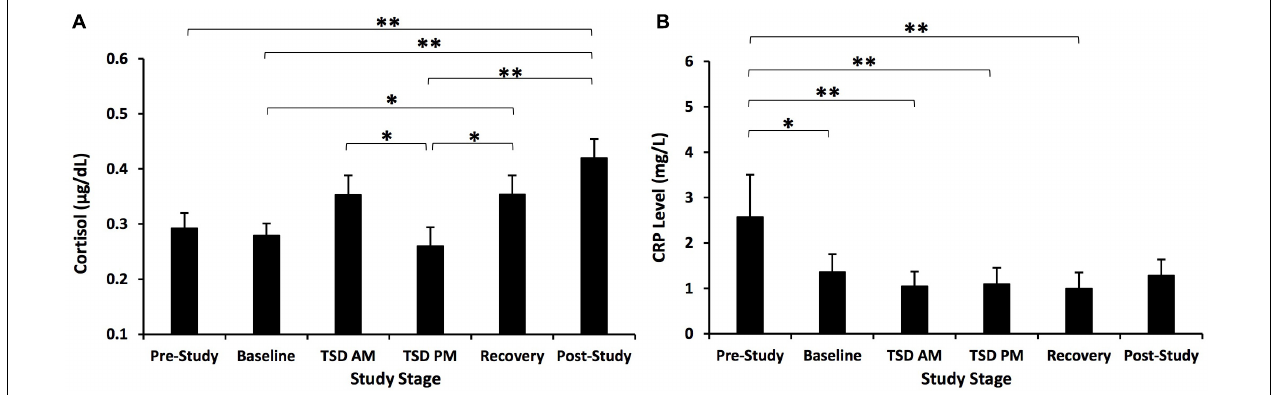
FIGURE 3 | Cortisol and C-reactive protein (CRP) changes across the study. (A) Cortisol showed a significant change across the study. Post hoc analyses showed that post-study cortisol was significantly higher than pre-study, baseline, and TSD PM cortisol. Cortisol at TSD AM was significantly higher than at TSD PM. Recovery cortisol was also significantly higher than at baseline and TSD PM. (B) CRP showed a significant time effect across the study. Post hoc analyses showed that pre-study CRP was significantly higher than CRP at all other time points except for post-study. N = 31 for the recovery point in (A) due to one participant withdrawn from the study during recovery night 1 and for the post-study point in (B) due to one participant’s loss of data due to a blood collection error; all other points are N = 32. * p < 0.05, ** p < 0.01. Data are not transformed and are presented as mean ± SEM.